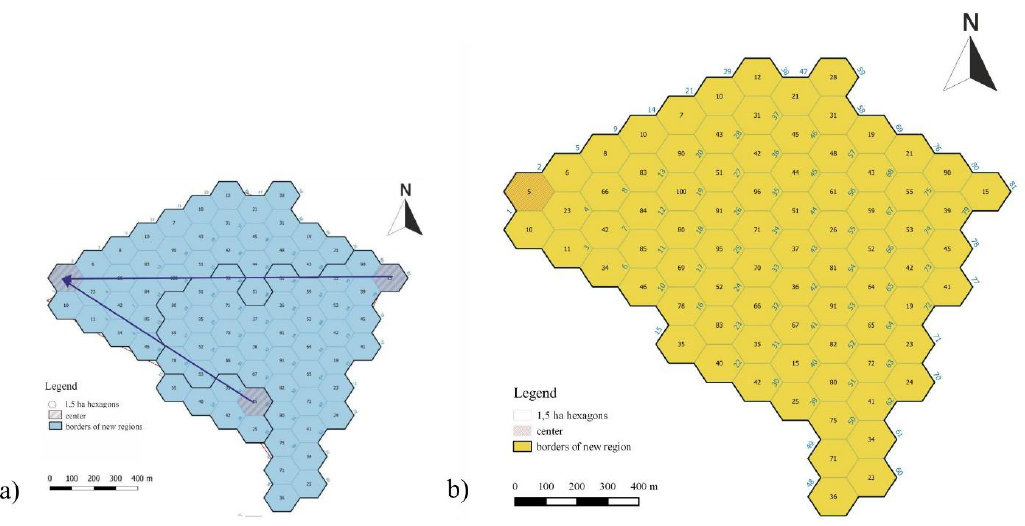
Figure 13. The third stage of aggregation of the landscape aesthetic value according to the minimum value decrease path; ( a ) the combination of values according to the principle of minimum value decrease; ( b ) new regions.